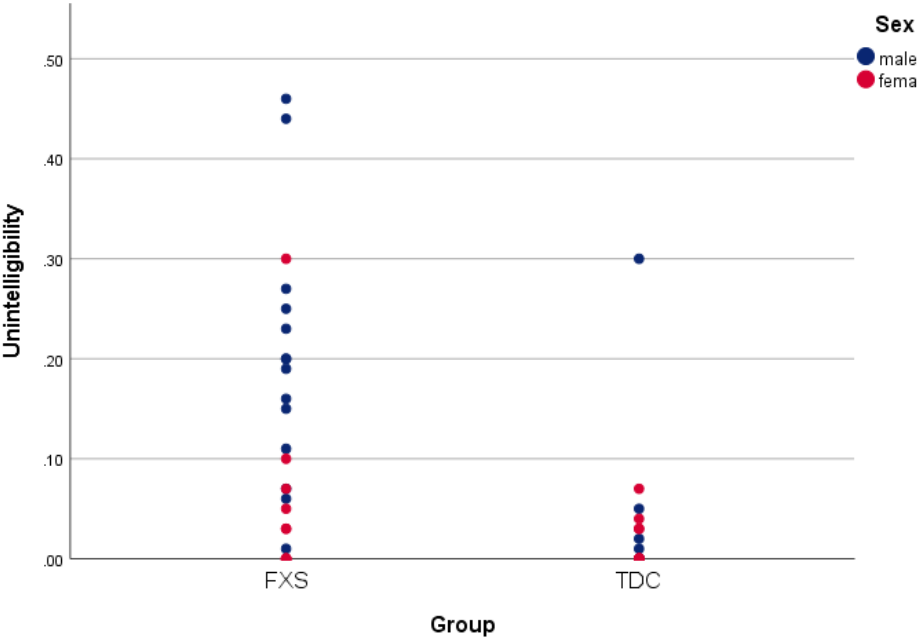
Figure 2. Unintelligibility scores are displayed for both FXS and TDC groups and separated by sex.